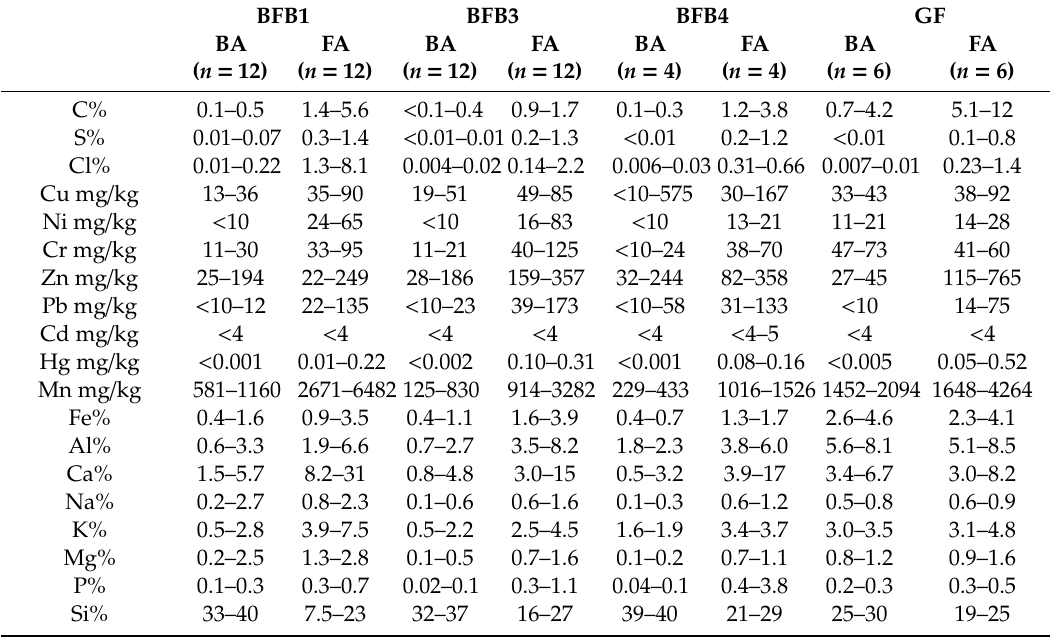
Table 6. Chemical composition of biomass ash samples (min–max), in dry